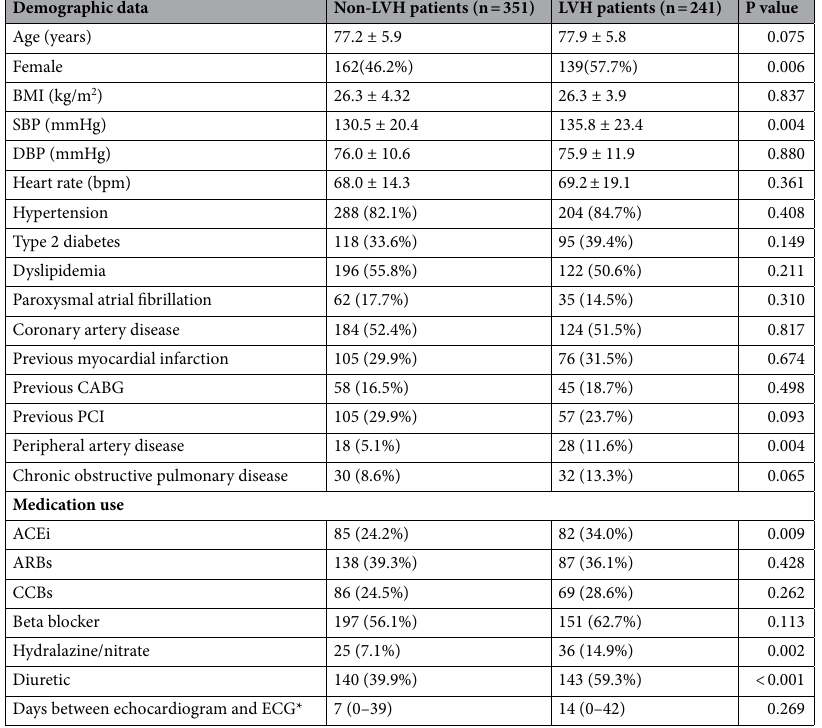
Table 1. Demographic data. Demographic data of the cohort, according to the left ventricular hypertrophy status evaluated by echocardiography. Values are mean ± standard deviation or n (%). ACEi angiotensin- converting enzyme inhibitors; ARBs angiotensin receptor blockers; BMI body mass index; CABG coronary artery bypass graft; CCBs calcium channel blockers; DBP diastolic blood pressure; PCI percutaneous coronary intervention; SBP systolic blood pressure. *Median and interquartile